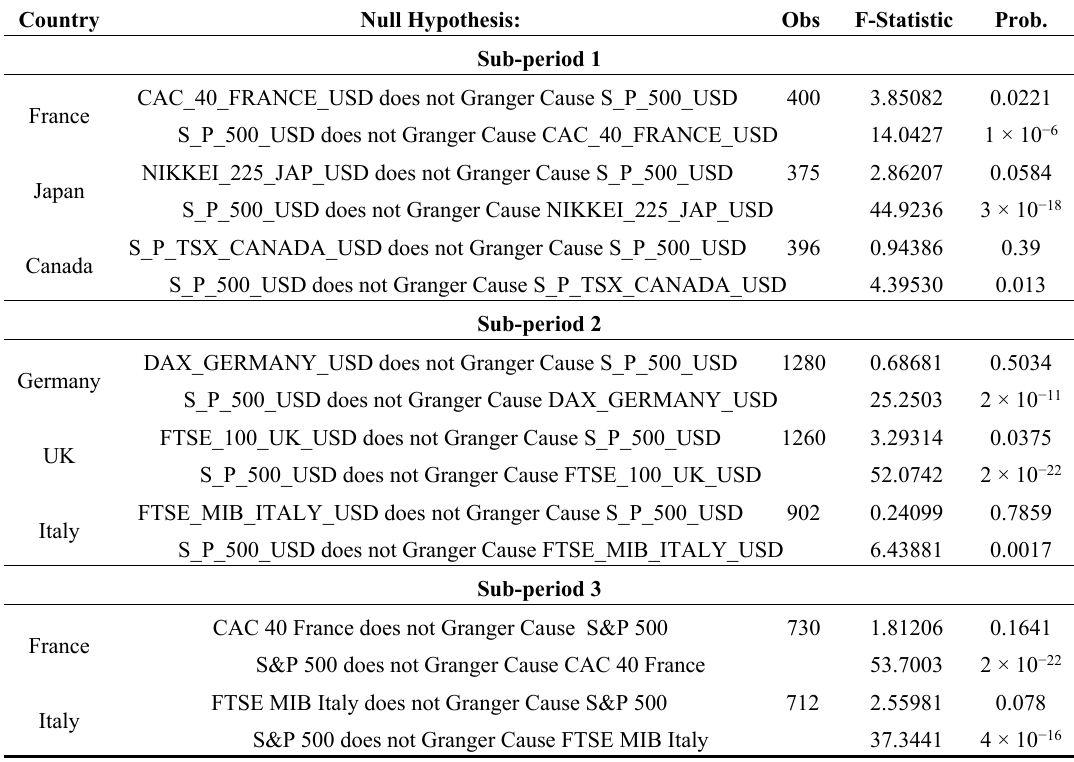
Table A4. Granger Causality